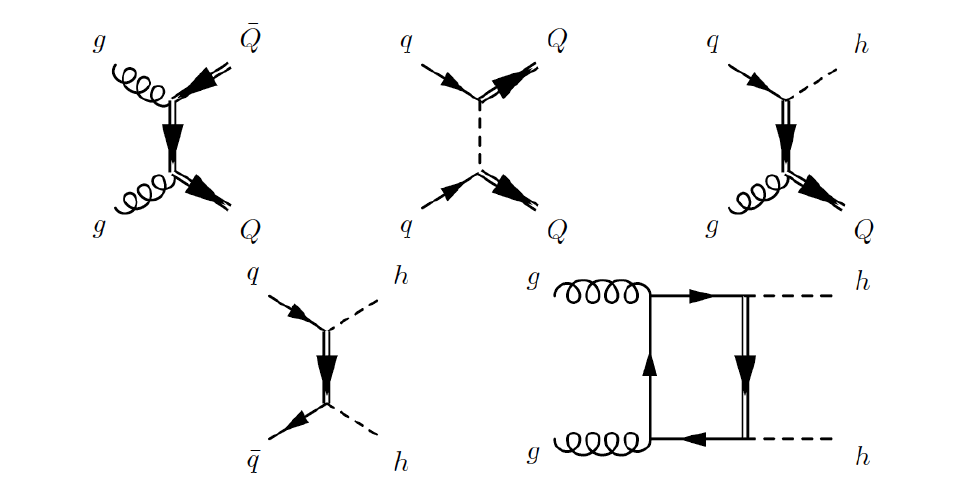
Figure 2 . Sample LO Feynman diagrams for each of the (cid:12)ve production channels described in the text and giving rise a VLQ-induced di-Higgs (cid:12)nal states, with the decay Q ! hq not explicitly